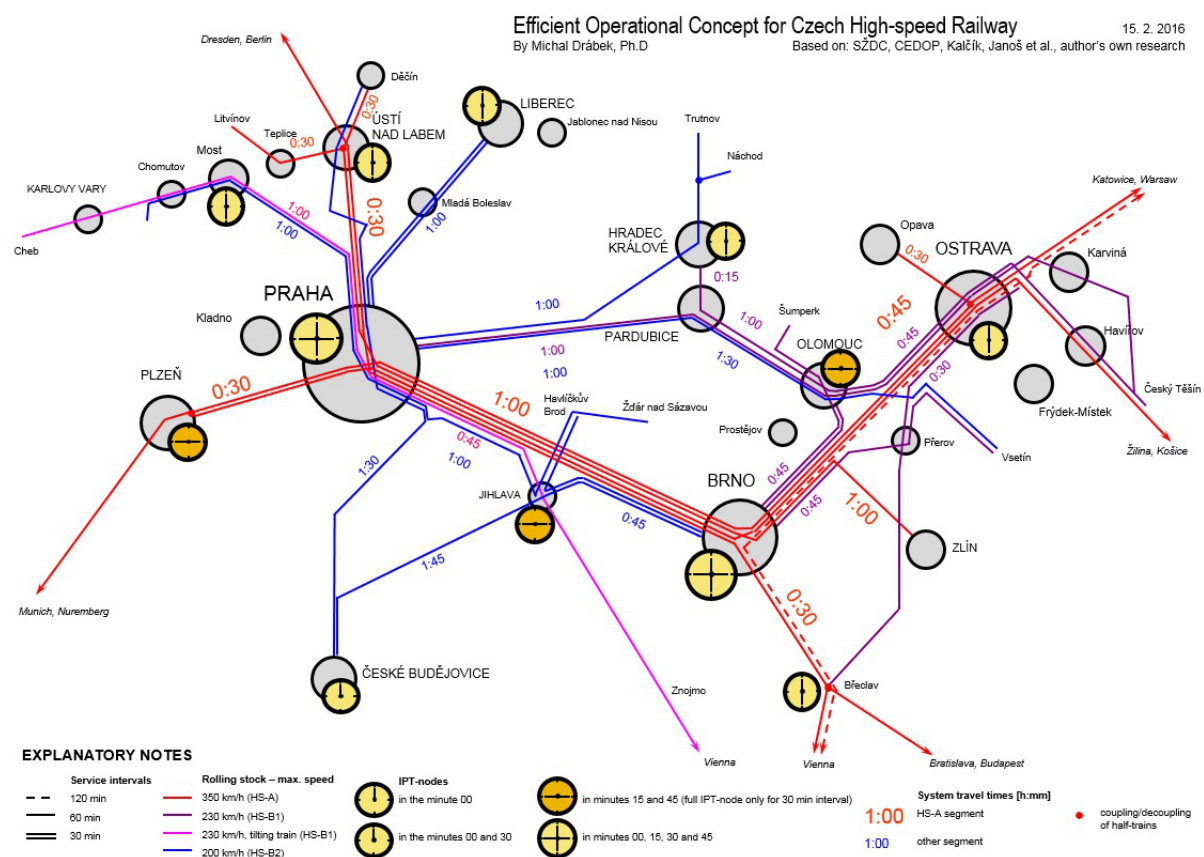
Figure 2. Proposed Operational Concept for HSL network of